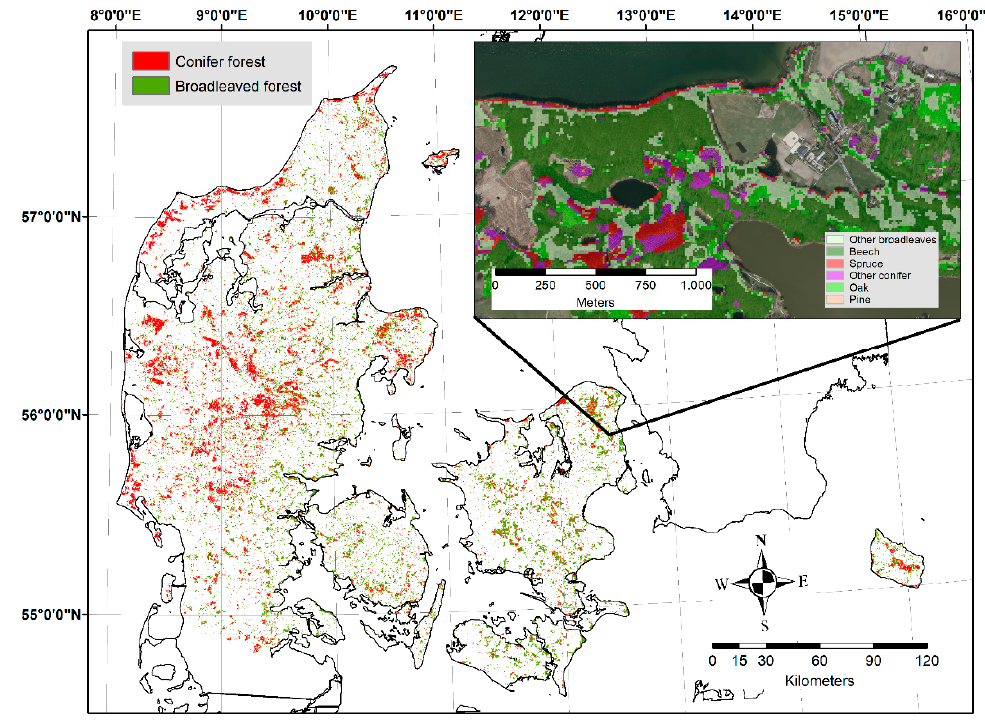
Figure 2. The resulting forest cover map of Denmark 2018 with details (see sections of forest type and species further below) from Frederiksdal Forest District, 17 km north of Copenhagen.